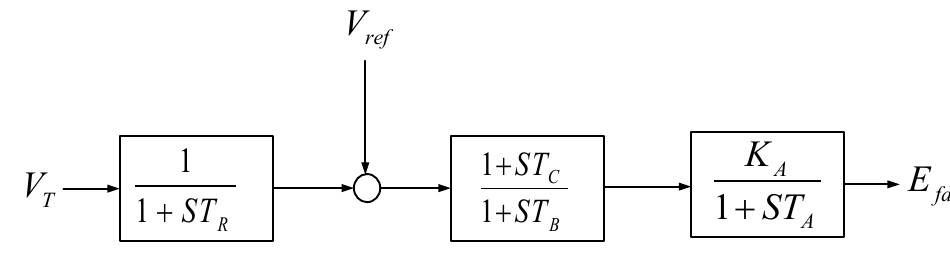
Figure 1. Block diagram of the exciter.